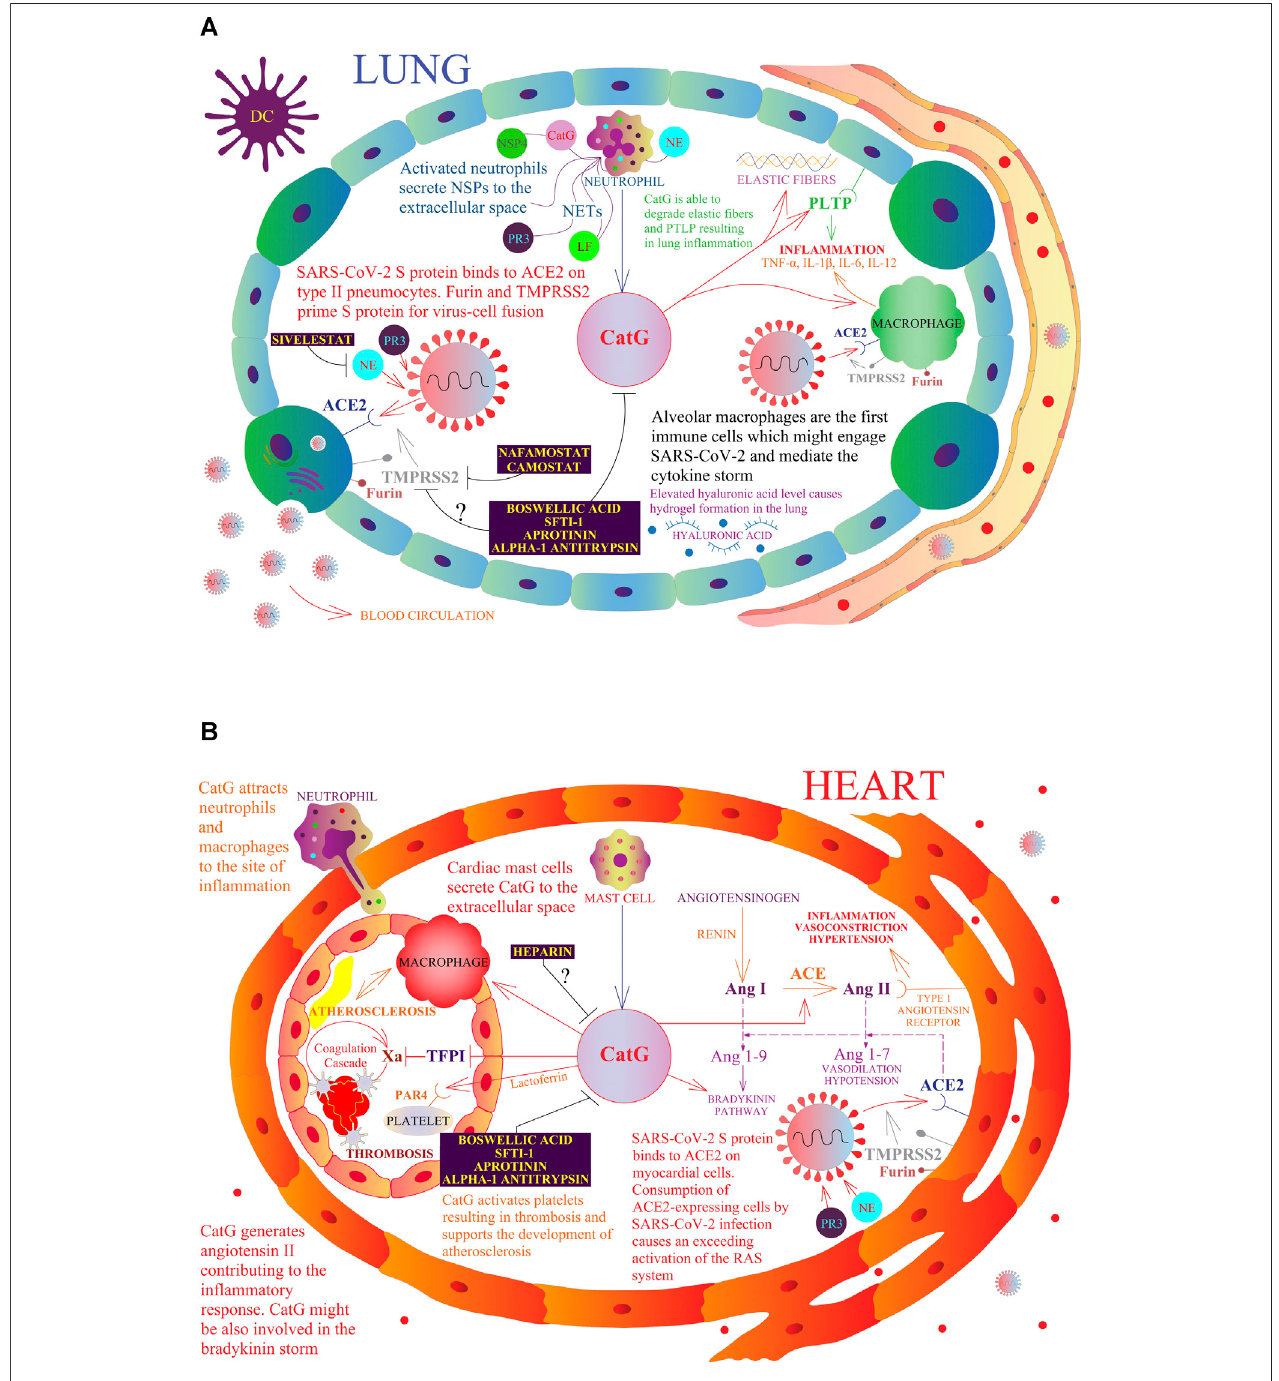
FIGURE2| AmodelofapossibleroleofNSPsintherespiratoryandcardiovascularsystemsinthecontextofCOVID-19.ThemultivariateroleofCatGinthehuman organism, including promotion of in fl ammation, hypertension, thrombosis, and possible involvement in COVID-19 pathogenesis. Resident macrophages, also called alveolar macrophages, are the fi rst immune cells that might engage SARS-CoV-2 (A) . At the site of infection, migrating neutrophils and mast cells secrete CatG to the extracellular space and induce the expression of proin fl ammatory cytokines by macrophages. SARS-CoV-2 S protein binds to angiotensin-converting enzyme 2 (ACE2)ontypeIIpneumocytesandmyocardialcells (B) .Furinandtransmembraneproteaseserinesubtype2(TMPRSS2)primetheSARS-CoV-2Sproteinforvirus-cell